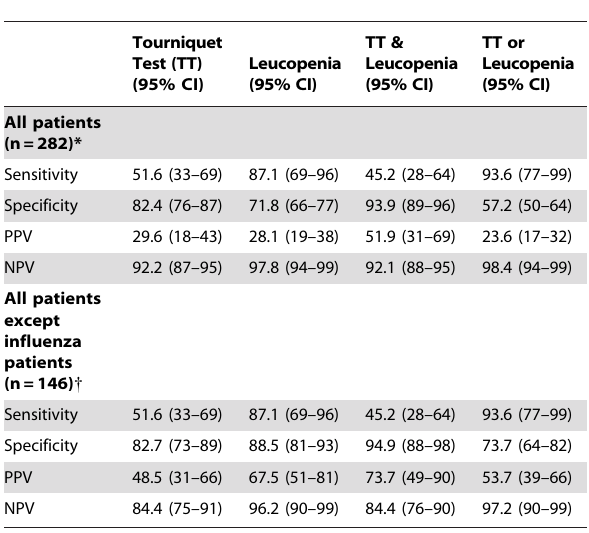
Table 3. Sensitivity, specificity, and predictive values of tourniquet test and leucopenia for laboratory-confirmed dengue.